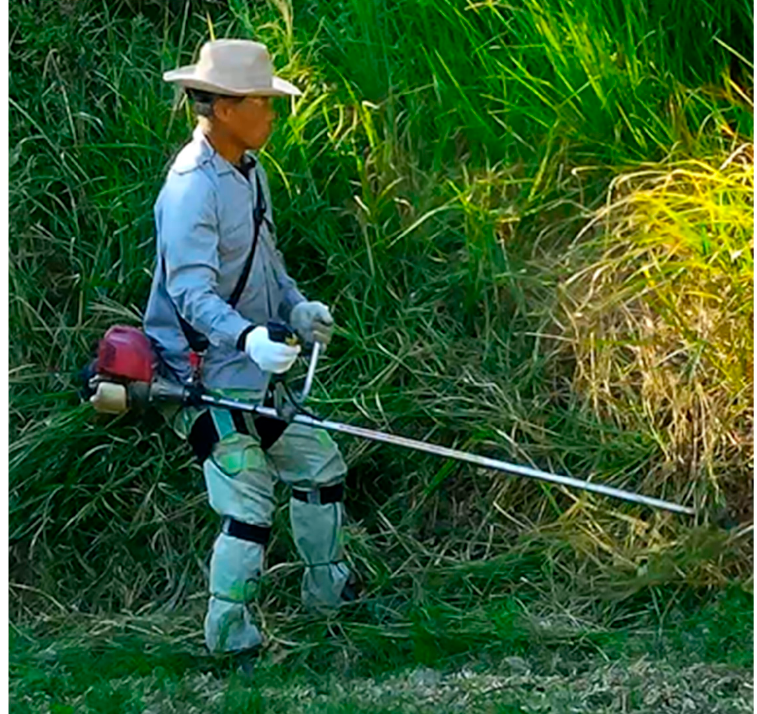
Figure 5. The U-handle-type mower.